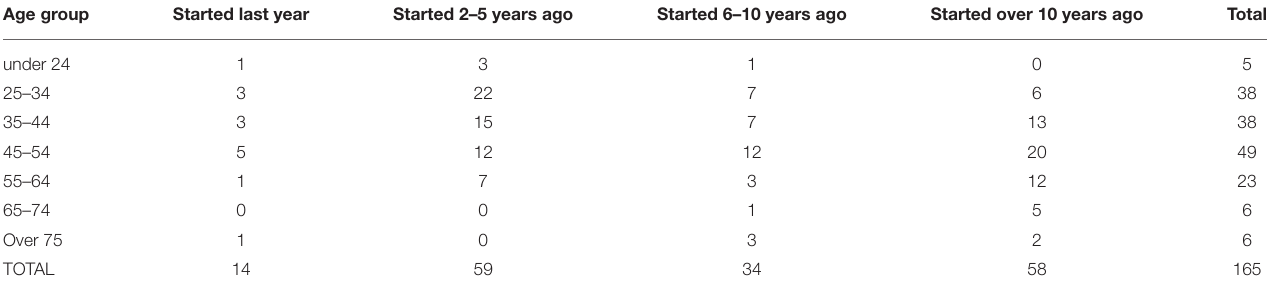
TABLE 7 | Age of beekeepers compared to length of time beekeeping.